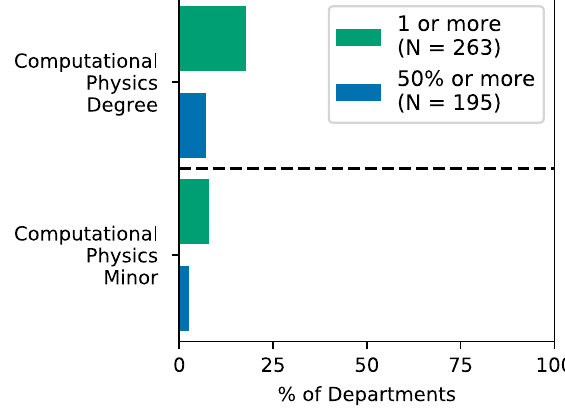
FIG. 5. For the 195 departments that have a simple majority of surveyed faculty reporting experience teaching computation in undergraduate physics, programs with a simple majority of surveyed faculty reporting that they department offers bachelor ’ s degrees in computational physics or minors in computational physics are shown (blue bars). The percentage of departments with at least 1 surveyed faculty member reporting that their department offers these formal programs is also shown (green